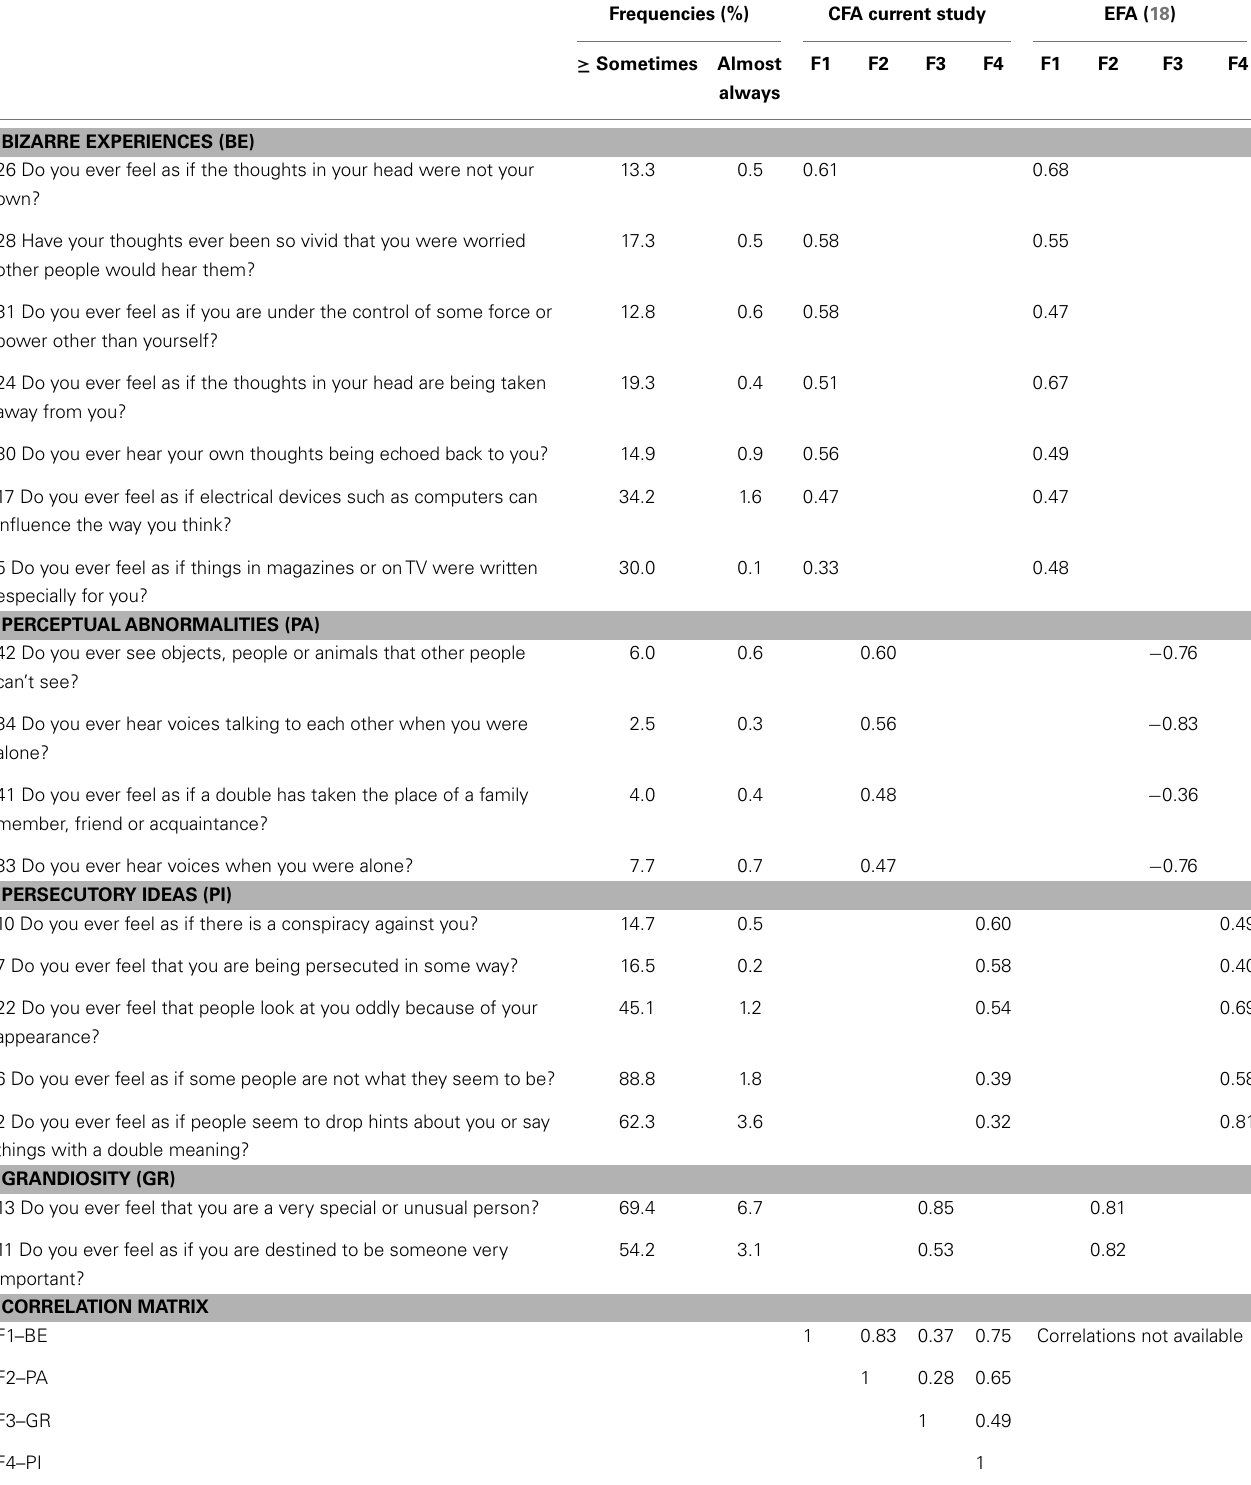
Table 2 | Community assessment of psychic experiences: positive symptoms frequency scores and factor analysis